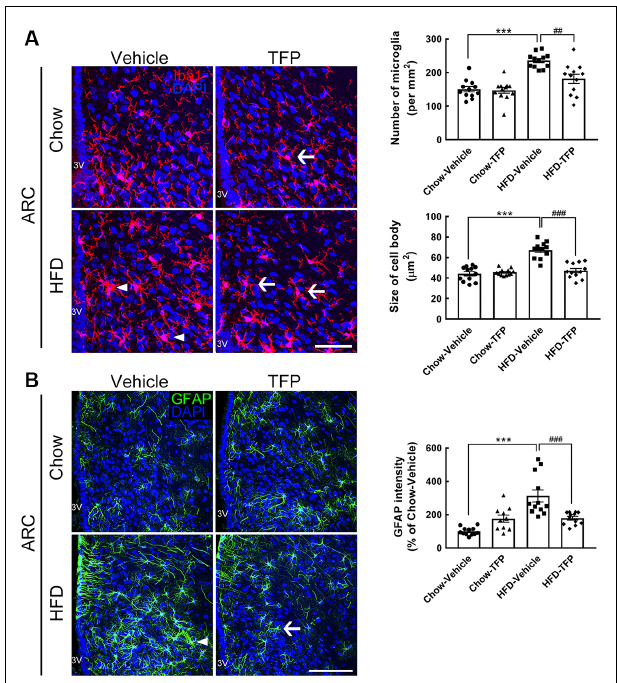
FIGURE 6 | Microglial activation and astrocytic hypertrophy in the ARC of obese mice were attenuated by TFP treatment for 4 weeks. Brain tissue sections were prepared from the four animal groups at 16 weeks post feeding ( Figure 4A ) and then subjected to Iba1 immunofluorescence (red in A ) and GFAP immunofluorescence (green in B ). DAPI nuclear counterstaining (blue in A,B ) was conducted. Representative active microglia (A) and hypertrophic astrocytes (B) are indicated by arrowheads in the HFD-vehicle group. Arrows show microglia or astrocytes with a small size and fine processes in chow-TFP or HFD-TFP. The number of Iba1 + microglia in the ARC (per mm 2 ) and their averaged cell size ( µ m 2 ) in the four animal groups were measured. In addition, the average cell body size of microglia in the two regions was measured. In addition, the intensity of GFAP immunoreactivity in the ARC was quantified. The results are presented as the mean ± SEM ( n = 12 tissue sections for Iba1 immunostaining from three animals per group; n = 9 tissue sections for GFAP immunostaining from three animals per group). Each dot represents one image. 3V, 3rd ventricle. *** p < 0.001 vs.